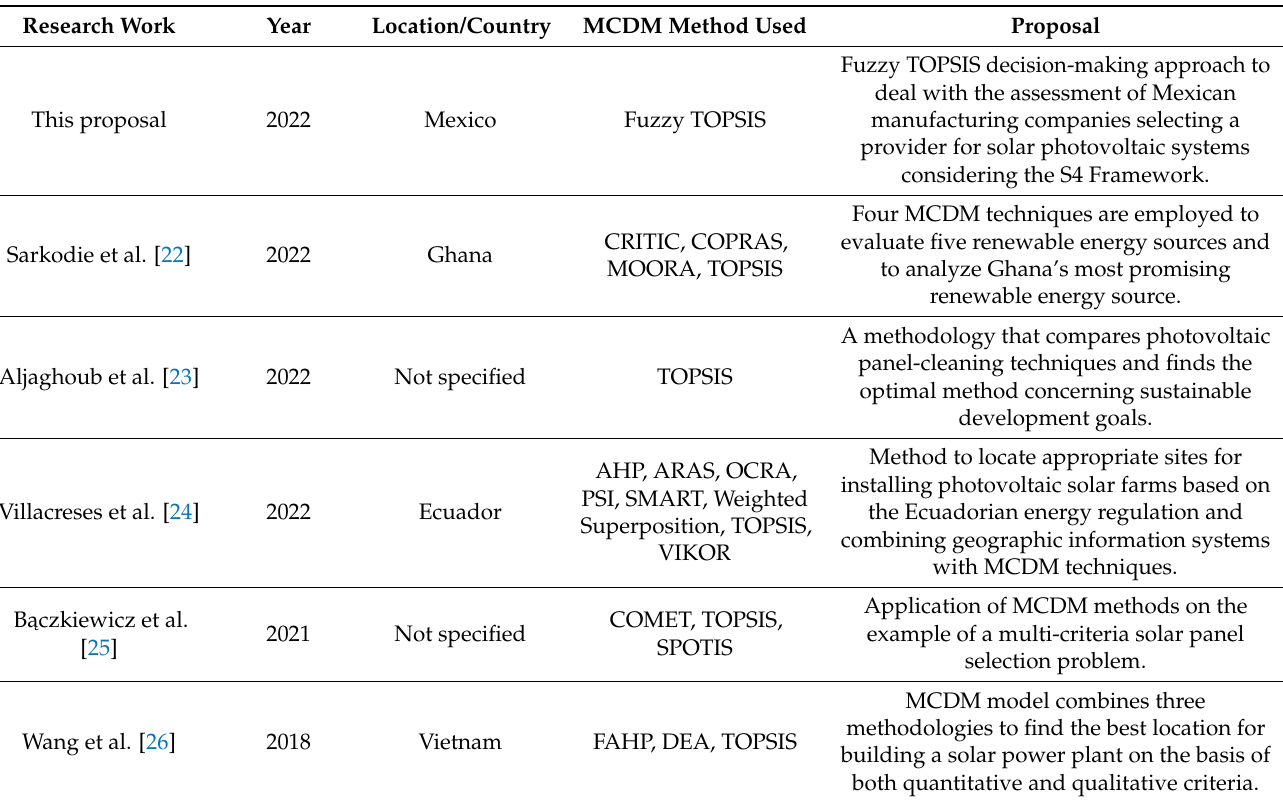
Table 2. Comparison among this proposal and others related to MCDM methods used in solar